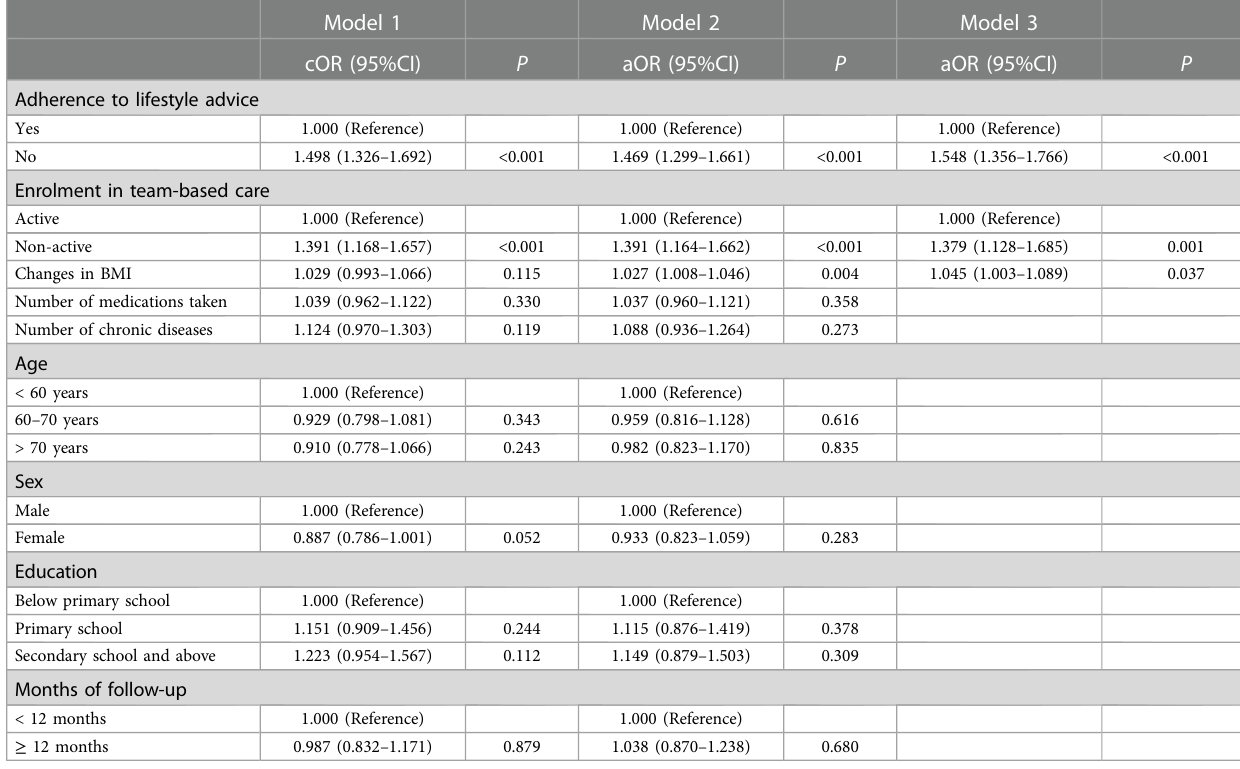
TABLE 4 Factors associated with no improvement in blood pressure and fasting plasma glucose at